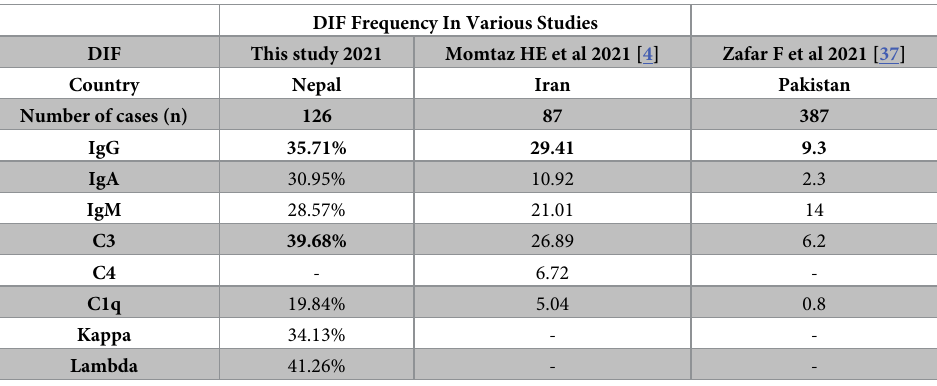
Table 7. DIF Frequency in various